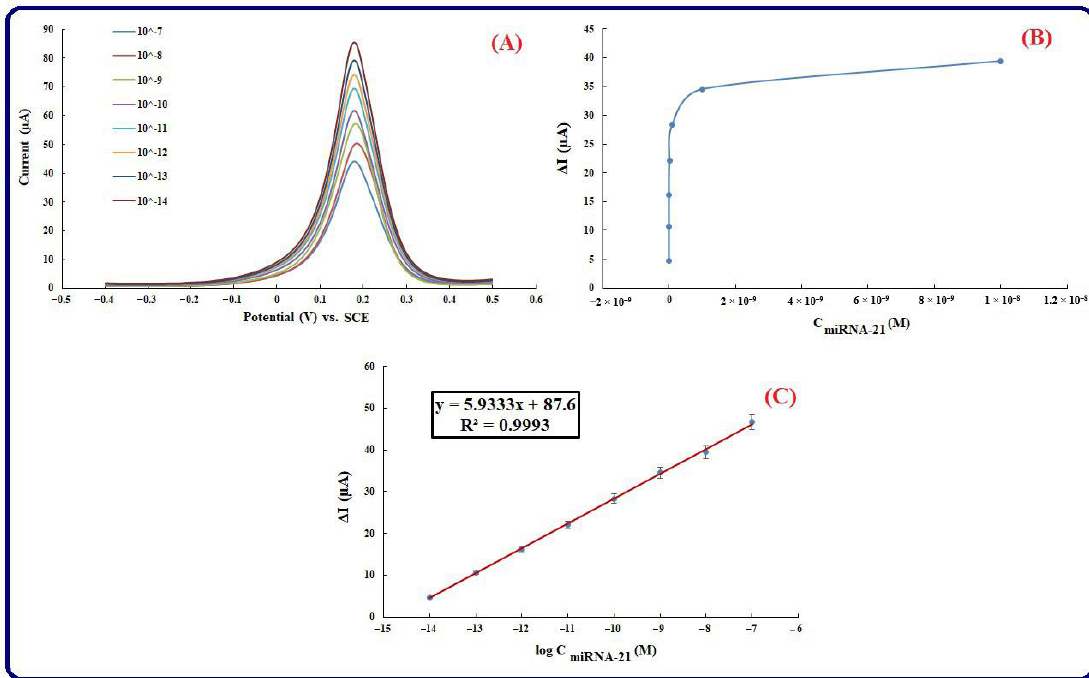
Figure 6. ( A ) DPVs (Equilibration time = 0, E initial = − 0.2 V, Estep = 0.1 V, E end = 0.5 V, Amplitude = 0.01995 V, frequency = 10 Hz) of the fabricated genosensor in various concentrations of miRNA-21 include: (10 − 14 –10 − 7 M). Supporting electrolyte is [Fe(CN) 6 ] 3 − /4 − , [Fe(CN) 6 ] 3 − /4 − is applied as a redox probe, ss-capture RNA concentration is 1 µ M, ( B ) Dependency of peak currents different concentrations (Calibration plot), ( C ) Plot of Ln C (concentrations). Table 2. Comparison of fabricated genosensor with other related methods for highly sensitive recognition of miRNA-21.